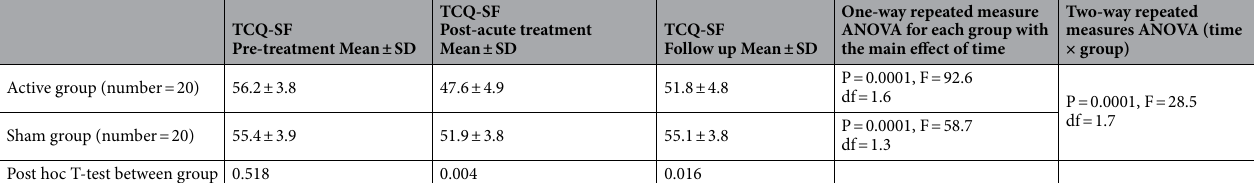
Table 4. Effects of HF-rTMS on craving measured by the tobacco craving questionnaire-short form (TCQ-SF) pre-treatment, post-acute treatment and follow-up.